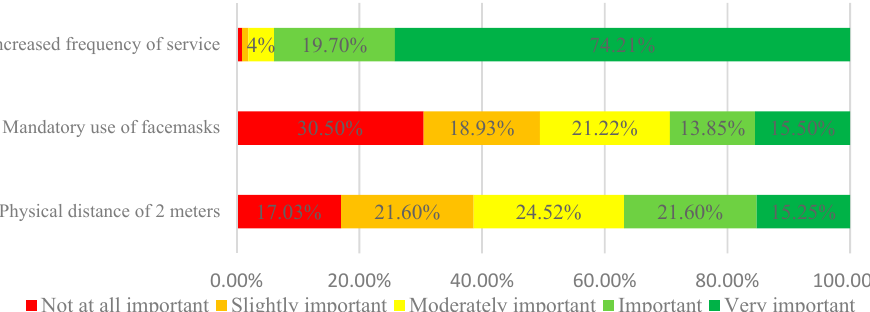
Figure 3. Perceptions toward the importance of various measures to remain on public transport post-pandemic.